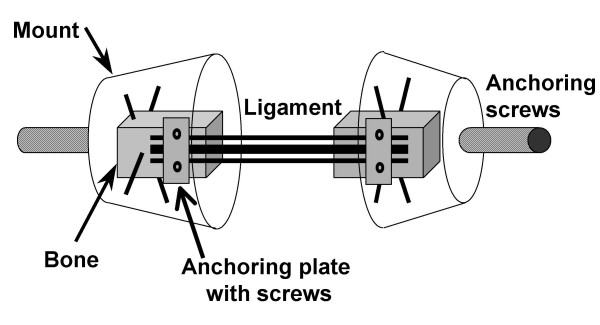
Schematic of a bone-ligament-bone preparation from Ivancic et al [19]. Anchoring plates ensured mid-substance tears during elongation.